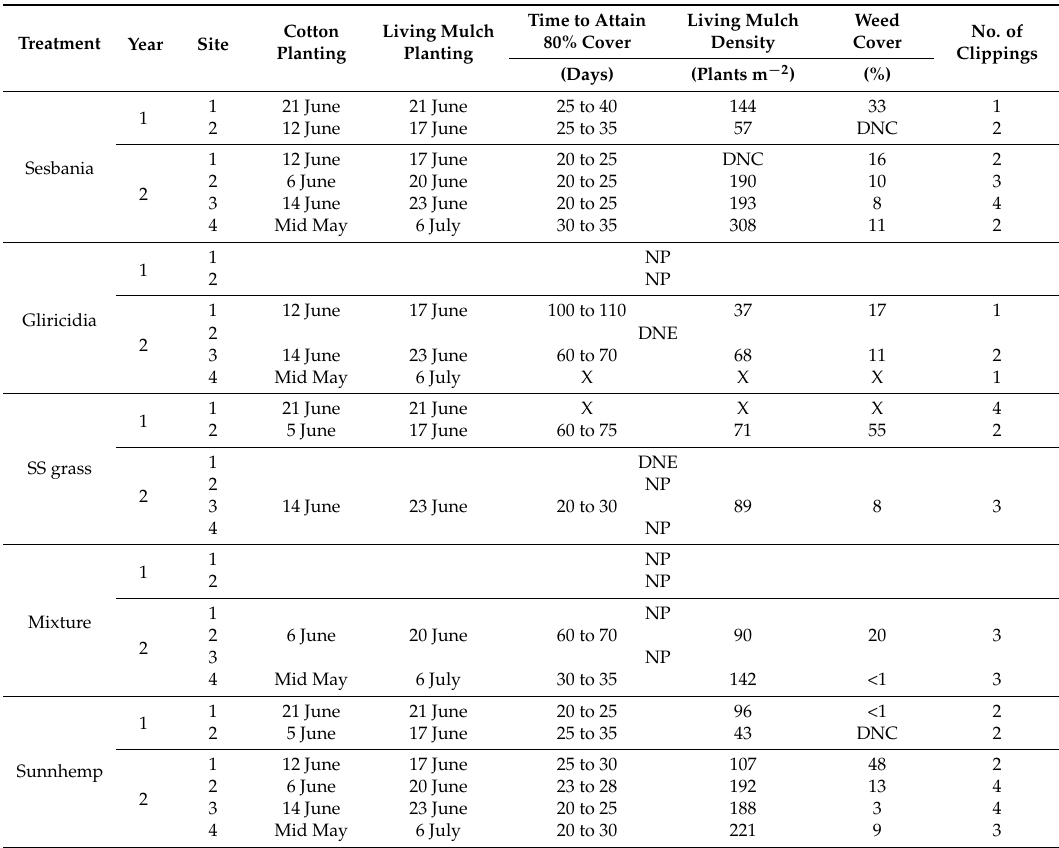
Table 2. Cotton and living mulch planting dates at each site-year. Number of days required by living mulches to achieve 80% surface cover is also shown, along with corresponding living mulch stand density and weed cover at that time. Total number of clippings is also listed a,b,c .